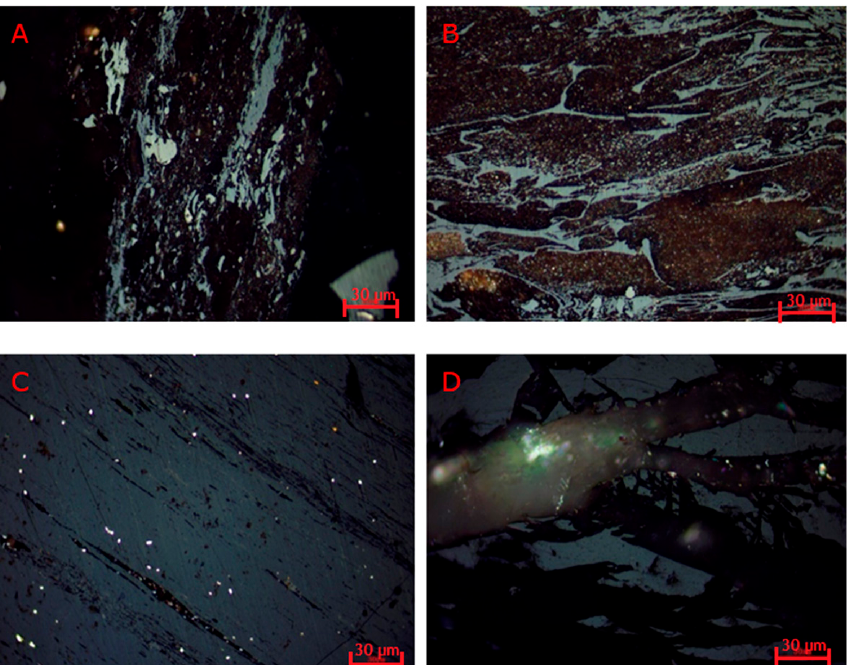
Figure 1. Microscope image of the minerals in coal sample: ( A ) grey clay glues with organic fragments; ( B ) grey clay fills in telinite cell lumen; ( C ) scatter distributed bright pyrite; ( D ) bright calcite veined fills in crack.